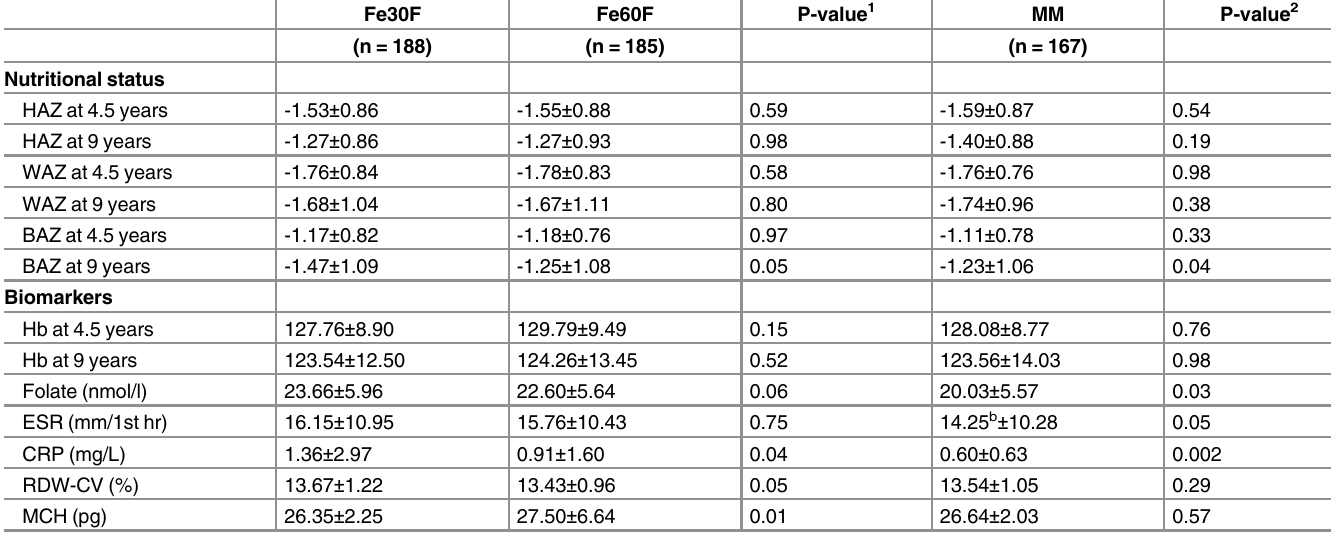
Table 3. Analysis of covariance of child nutritional status and plasma biomarkers in different supplementation